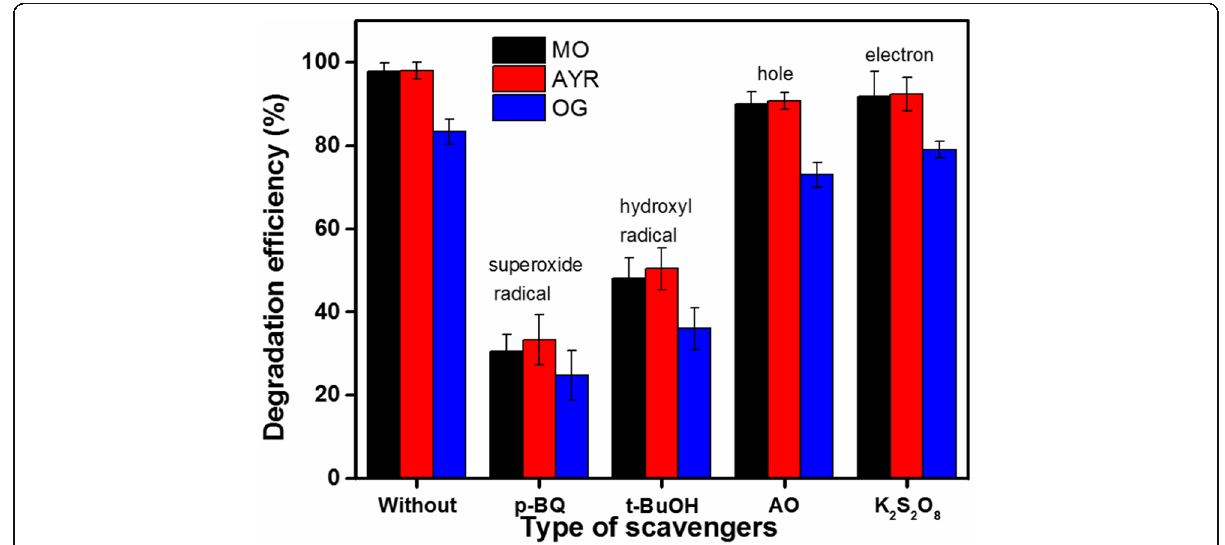
Fig. 13 The degradation efficiencies of monazo dyes over ZnO/Fe 3 O 4 /g-C 3 N 4 -50% in the presence of various scavengers